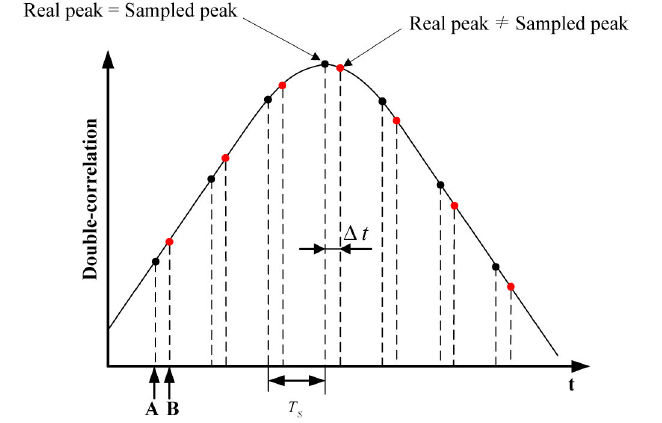
Figure 4. Timing offset between real peak and sampled peak for correlation